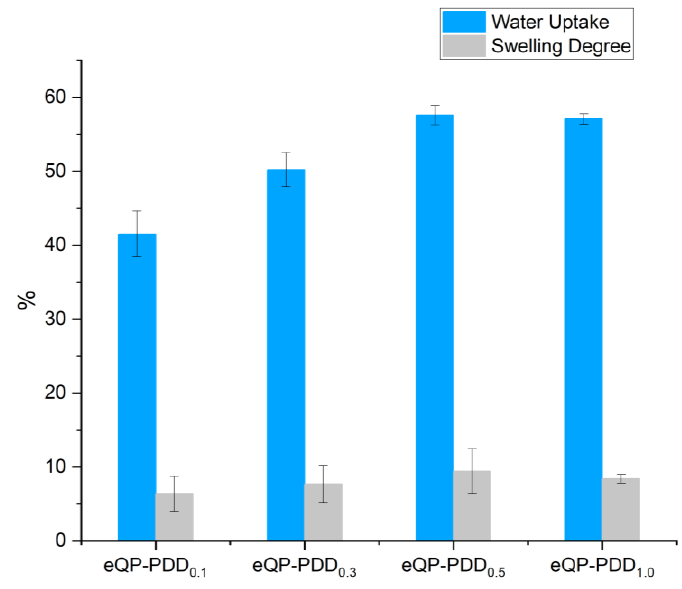
Figure 9. WU and SD of eQP-PDD x AEMs.